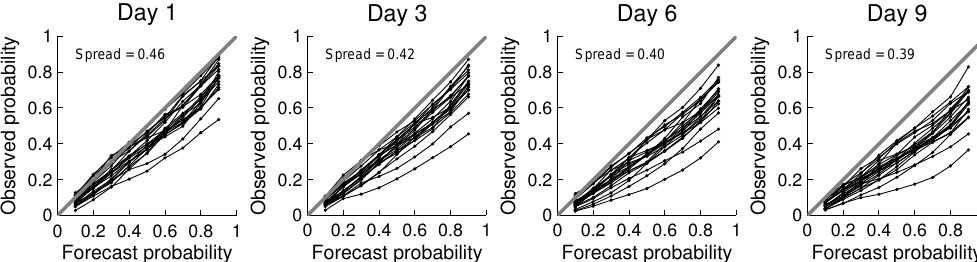
Figure 4. Reliability of the multimodel ensemble (system E) for all individual catchments. The spread represents the square root of mean ensemble variance averaged over all